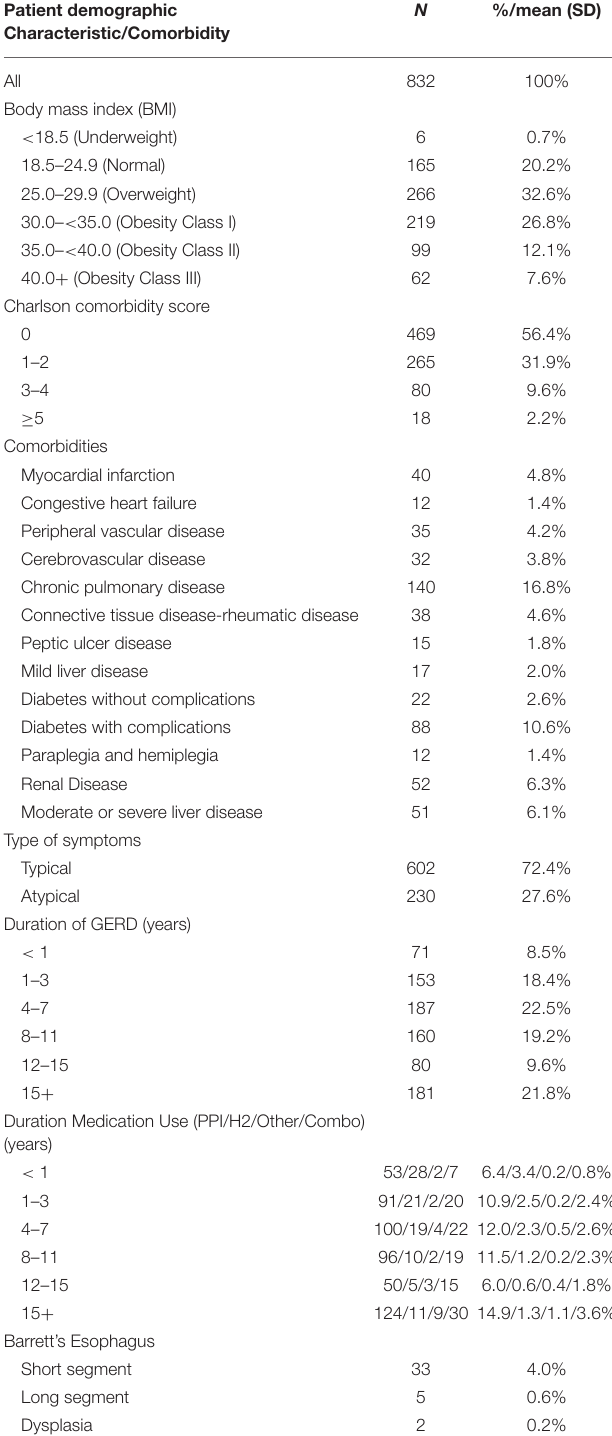
TABLE 2 | Baseline clinical characteristics of patients presenting to the HBC.